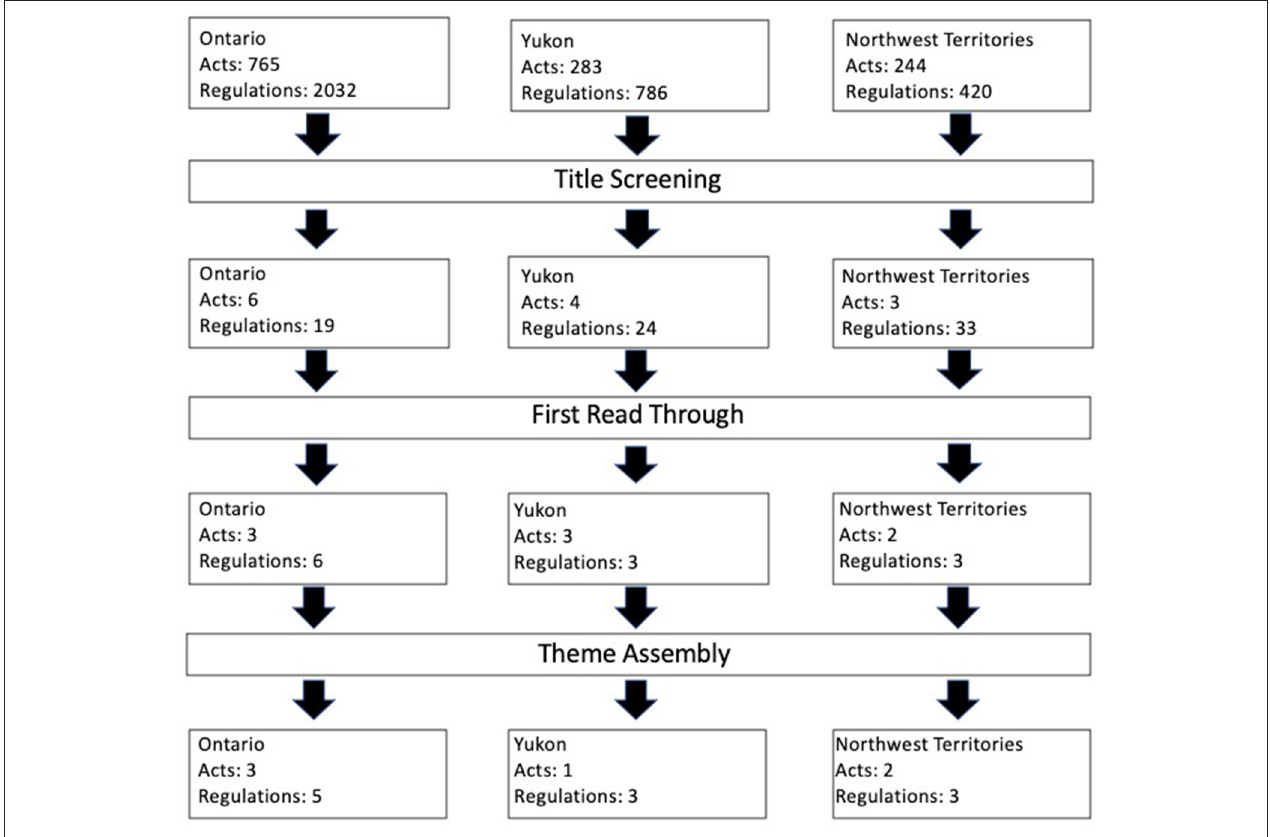
FIGURE 2 | Policy title screening